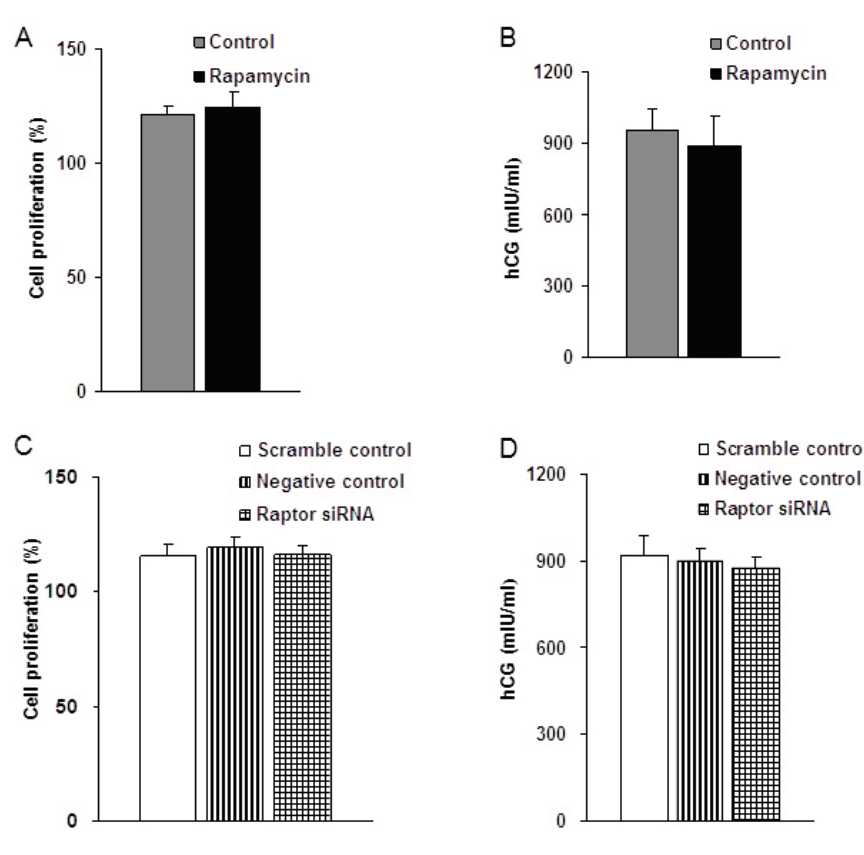
Figure 2. Raptor mRNA expression was markedly decreased after raptor silencing. Quantitative-PCR analysis showed that raptor gene was significantly silenced in the cells transfected with raptor siRNA. Values are present as mean ± SD. n = 6, * p < 0.01 vs. scramble control and negative control by Kruskal-Wallis test followed by Mann-Whitney U -test.